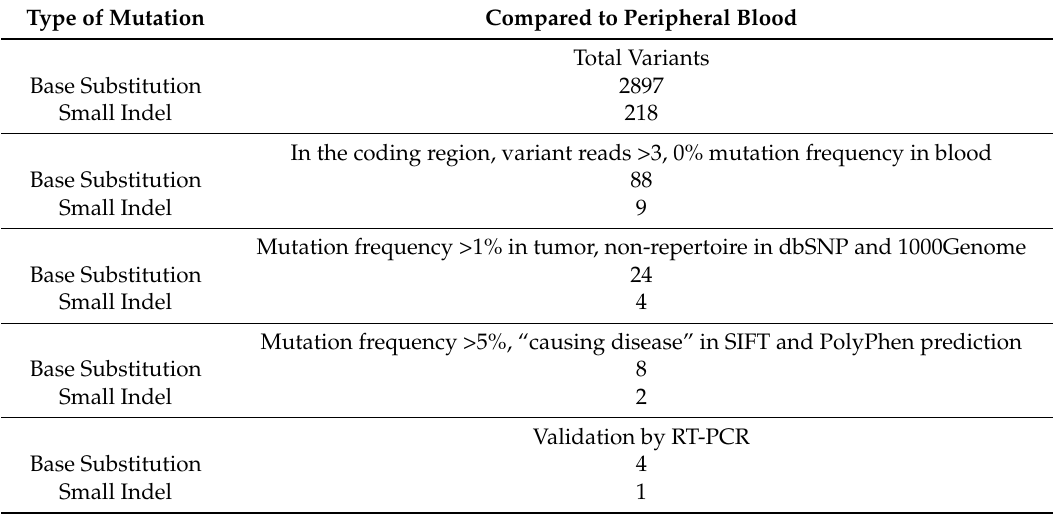
Table 1. Number of somatic variants after applying different selection